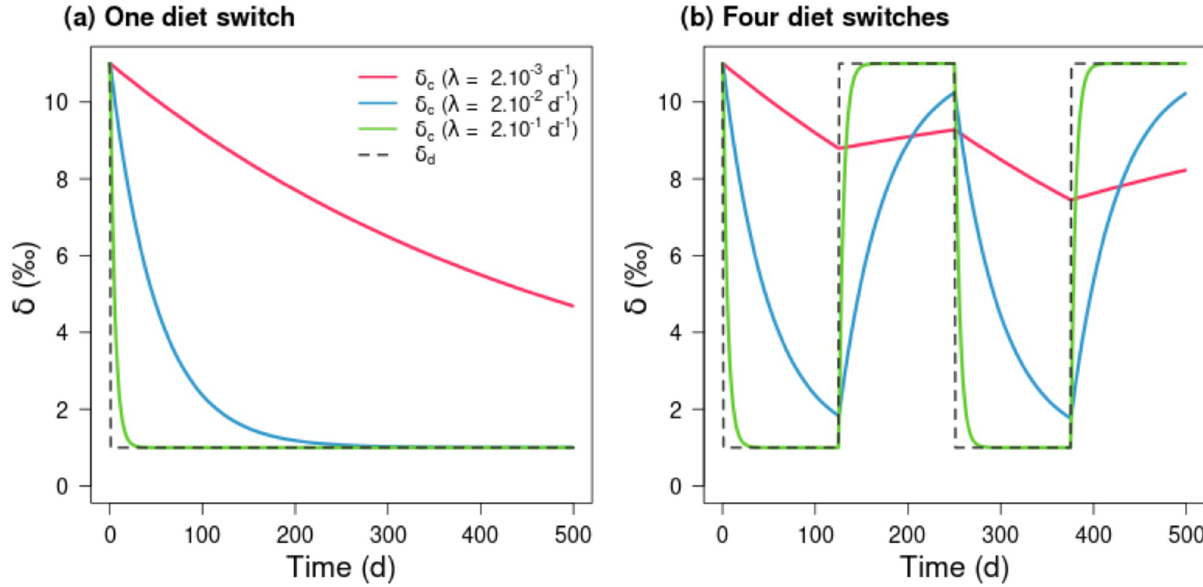
Fig 2. Simulated isotopic values of consumer ( δ ( t )) during 500 d, for contrasted isotopic turnover rates ( λ solid lines) and experiencing a variable c diet ( δ d ( t ) dashed line) resulting from one (a) or four diet-switches (b) between two food sources ( δ s ( a ) = 0 ‰; δ s ( b ) = 10 ‰). The λ values were constant and low λ = 2.10 − 3 d -1 (red), intermediate λ = 2.10 − 2 d -1 (blue), and high λ = 2.10 − 1 d -1 (green) corresponding to the range of values of Thomas & Crowther (2015) [31]. The frequencies of diet shift are ω = 0.002 d -1 (a) and ω = 0.008 d -1 (b). The ratios ω / λ were respectively 1, 0.1 and 0.01 (a) 4, 0.4 and 0.04 (b). Note that for each of the food source, the trophic discrimination factors ( Δ ) were set to 1 ‰. s ( i )